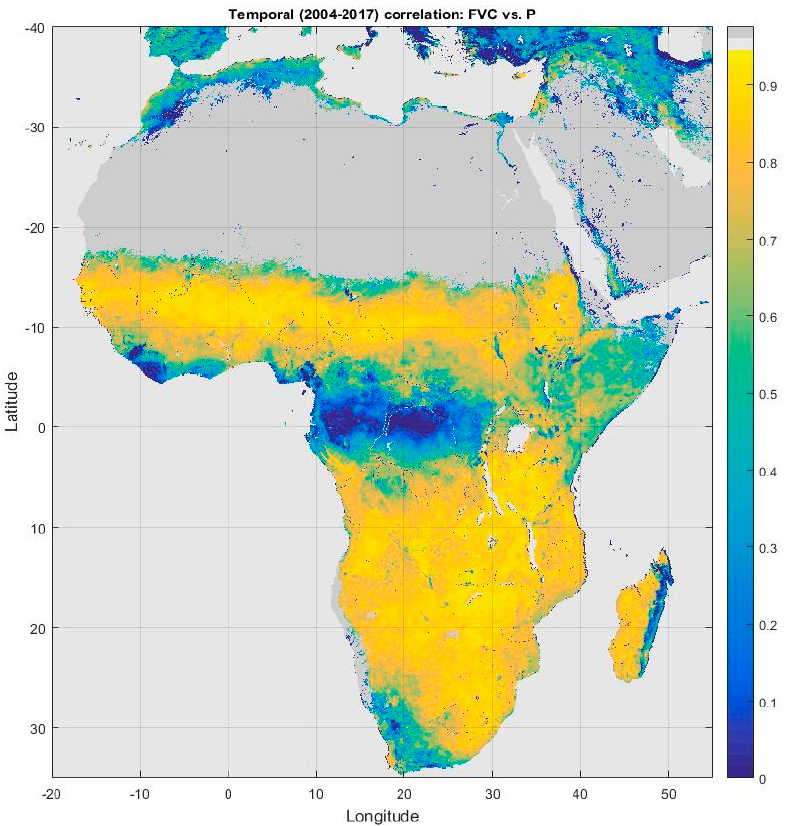
Figure 12. Pearson correlation coefficient between time series of FVC and 3-month accumulated precipitation for the 2004-2017 period.